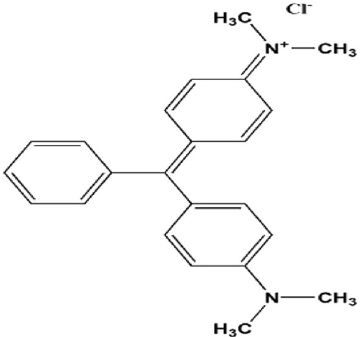
Fig. 1 Structural formula of Malachite